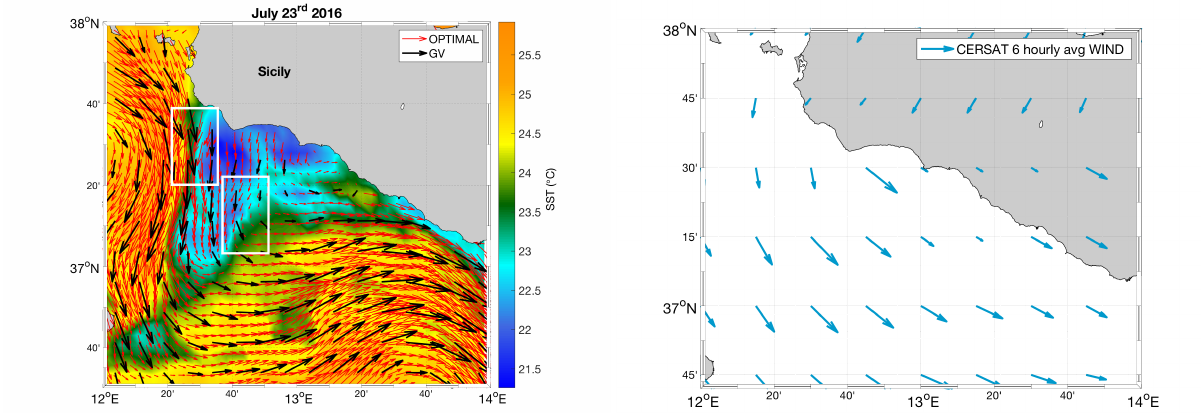
Figure 5. Left panel: Geostrophic Velocities (black arrows, 1/8 ◦ horizontal resolution) and Optimal Velocities (red arrows, 1/24 ◦ horizontal resolution) over sea-surface temperature (SST) in ◦ C—23 July 2016 (the white boxes are referenced in Section 4.2). Right panel: CERSAT/IFREMER 6 hourly averaged surface winds—20–22 July